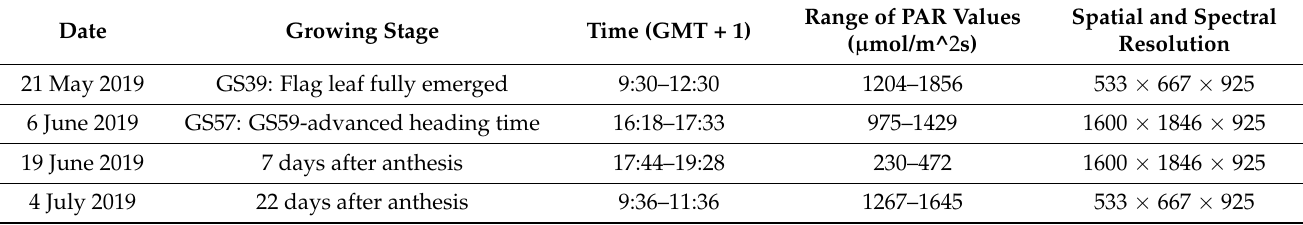
Table 1. Summary of image acquisition conditions for the data collected in this